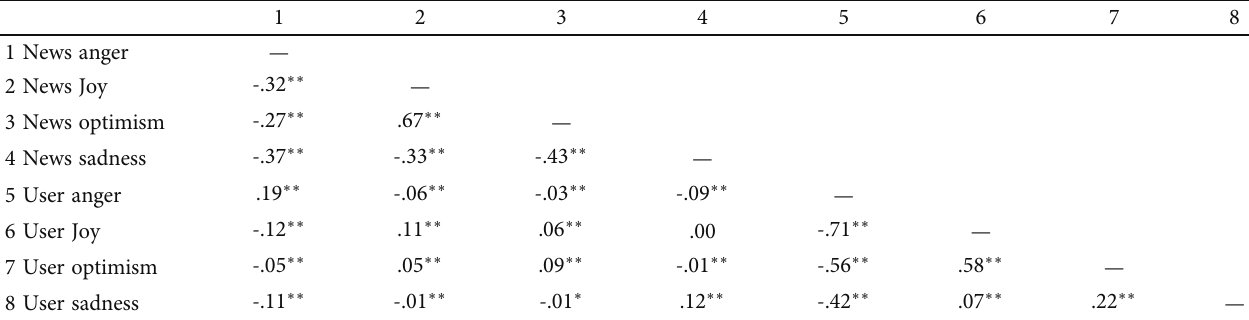
Table 6: The Guardian correlation matrix showing Spearman ’ s Rho coe ffi cients between news and user emotion scores.